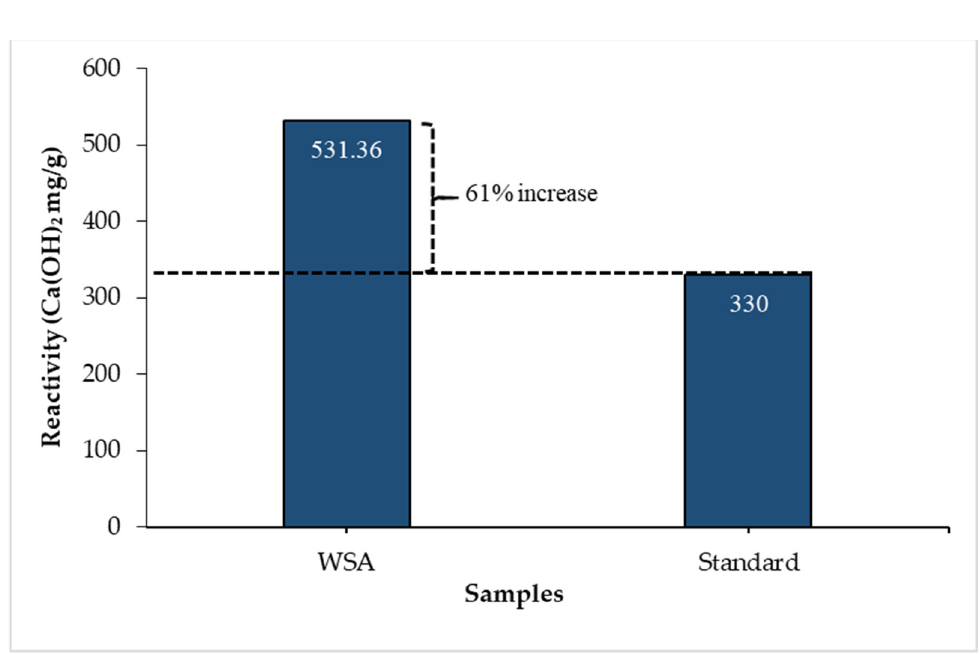
Figure 5. Pozzolanic potential of WSA using Chapelle activity.